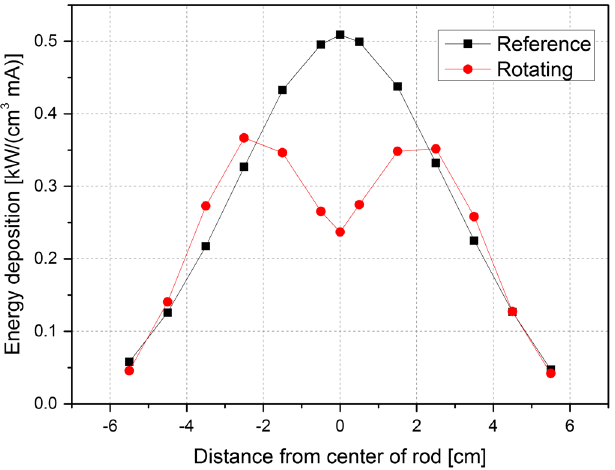
FIG. 13. Location of the control volumes in the MCNPX